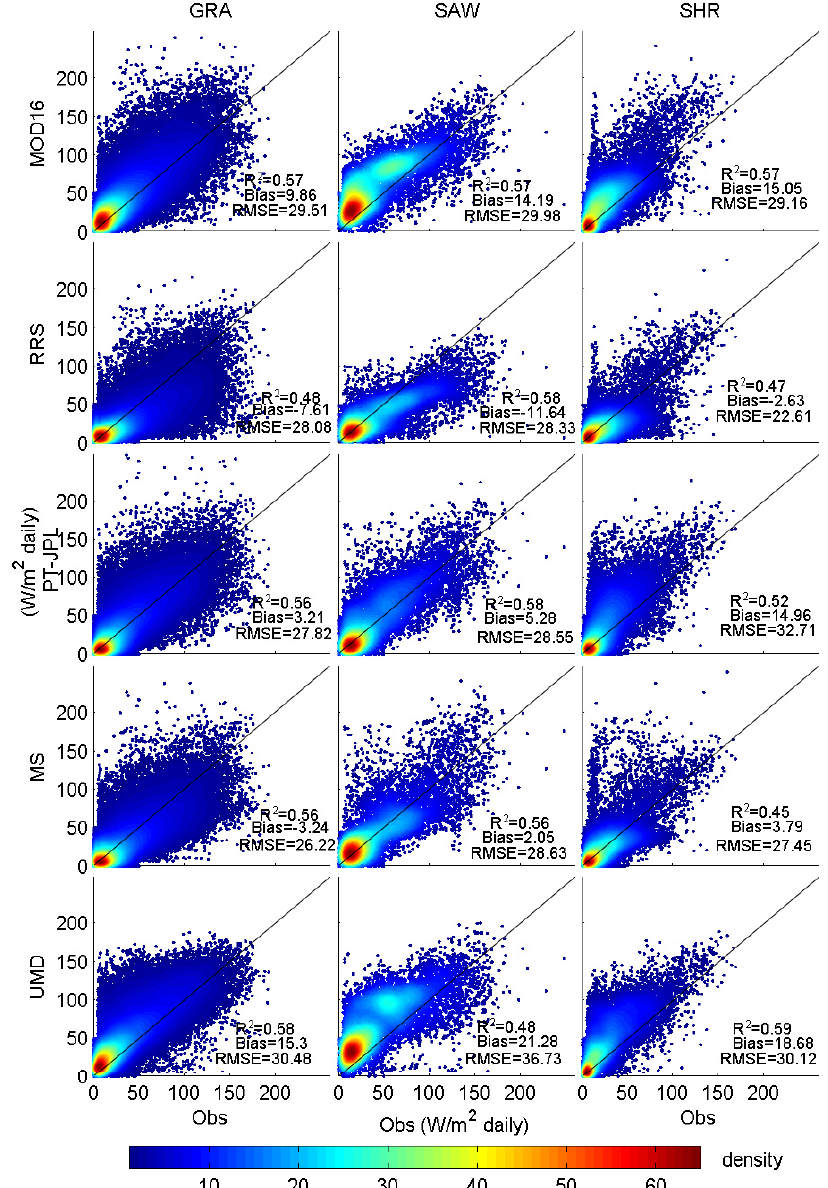
Figure 4. Observed and estimated LE at EC sites driven by MERRA meteorological data during the period 2000–2009.